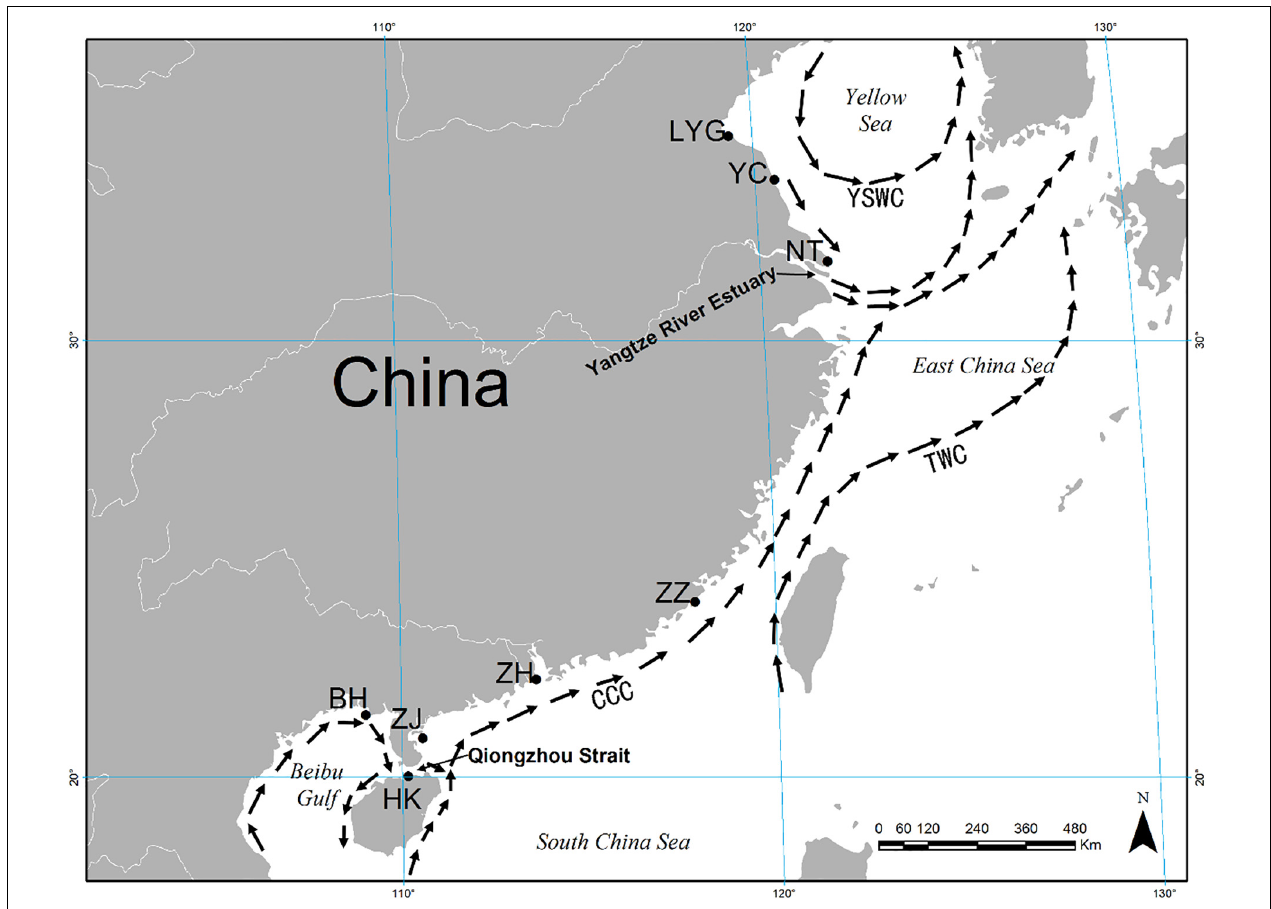
FIGURE 1 | Map showing eight sampling localities for Meretrix meretrix and summer oceanic currents along the coast of China. CCC, China Coastal Current; YSWC, Yellow Sea Warm Current; TWC, Taiwan Warm